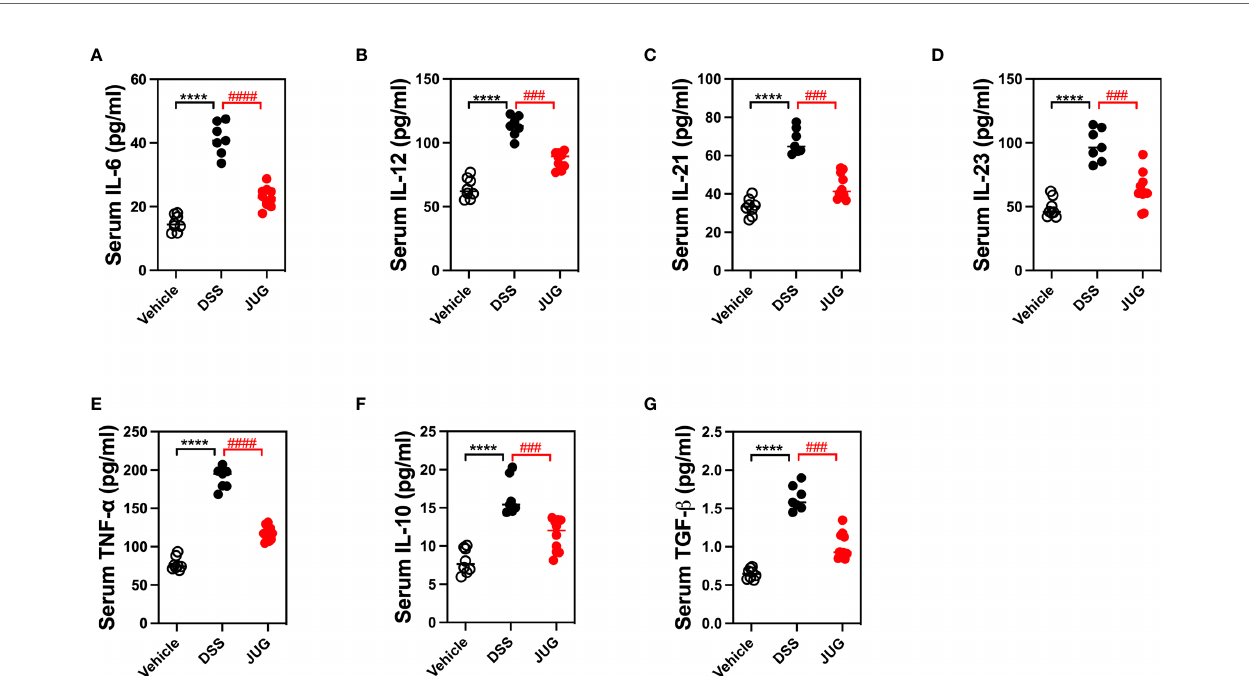
FIGURE 3 | ELISA analysis to test DSS-induced in fl ammation. ELISA was used to analyze serum cytokines, including IL-6 (A) , 12 (B) , 21 (C) , 23 (D) , TNF- a (E) , IL-10 (F) , and TGF- b (G) . **** P < 0.0001, ### P < 0.001, #### P <